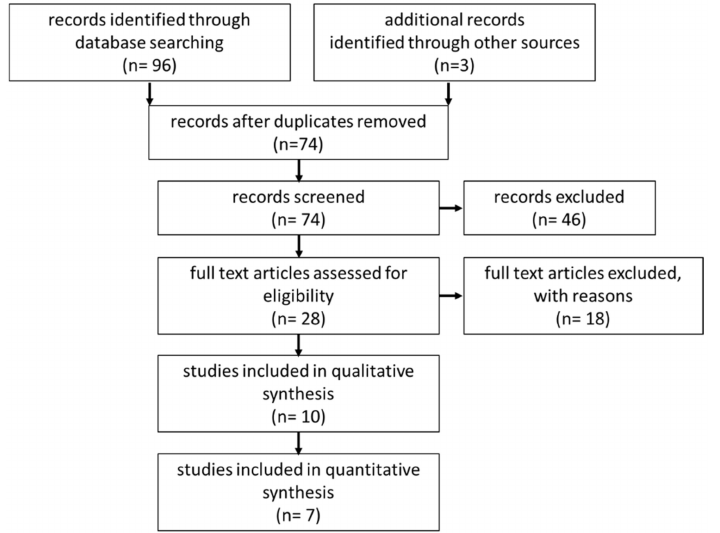
Figure 1. PRISMA-Flowchart of workflow in the systematic review.